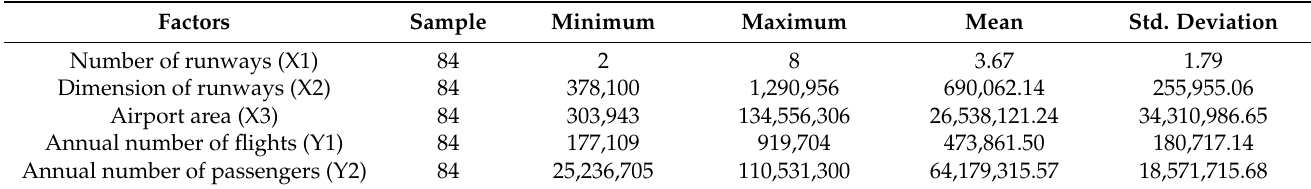
Table 3. The descriptive statistics of the collected data during 2016–2019.